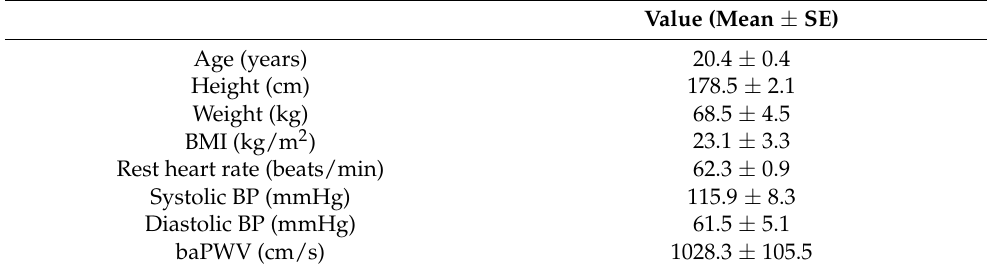
Values are means SE. BMI, body mass index; BP, blood ±